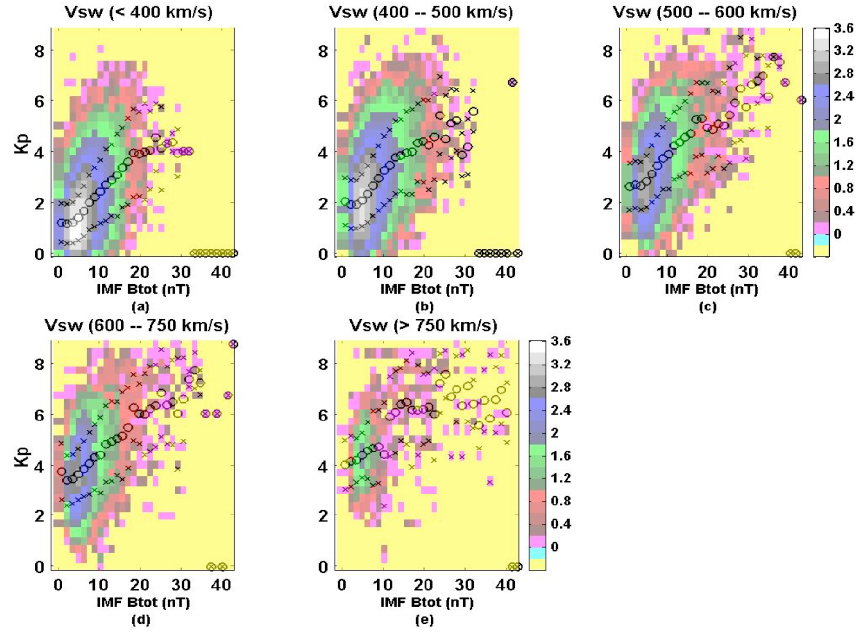
Fig. 3. (a) to (e) show the reduced histogram of K p index as a function of IMF magnitude B tot after localizing the solar wind speed V sw : (a) V sw < 400kms − 1 ; (b) 400kms − 1 ≤ V sw < 500kms − 1 ; (c) 500kms − 1 ≤ V sw < 600kms − 1 ; (d) 600kms − 1 ≤ V sw < 750kms − 1 ; and (e) 750kms − 1 ≤ V sw . The different panels, constructed similarly to those in Fig. 1, clearly reveal the inherent variation of (average) K p with both B tot and V sw ; whereas Fig. 1 shows only the overall K p variability with a single parameter. Compared to Fig. 1b and c, the localized K p distributions in different V sw bins are more compact, yielding more accurate K p values to characterize magnetospheric